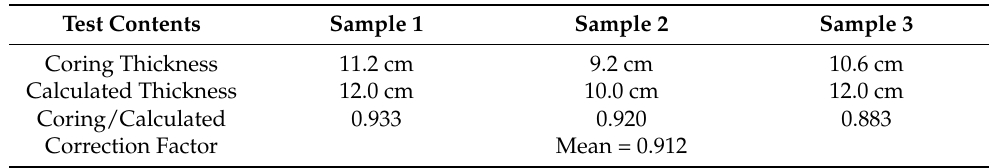
Table 4. Thickness correction factor.